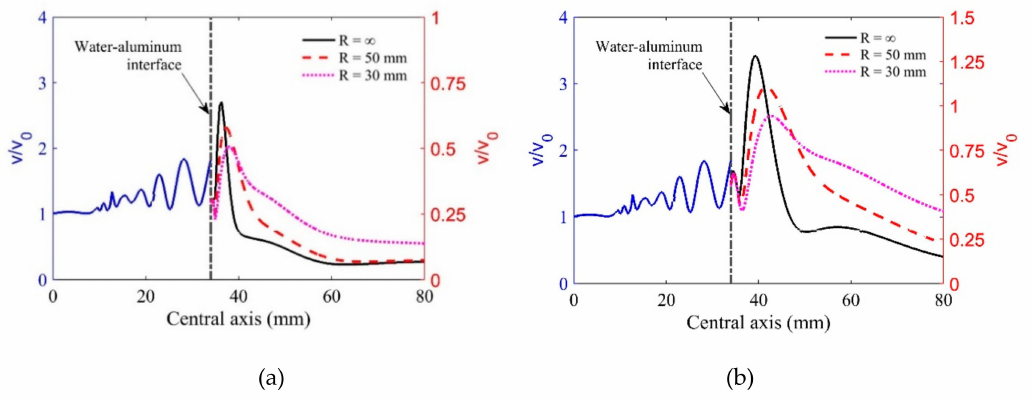
Figure 4. Particle velocities on the central axis in water–aluminum media: ( a ) longitudinal wave at the incidence angle of 10 ◦ and ( b ) shear wave at the incidence angle of 20 ◦